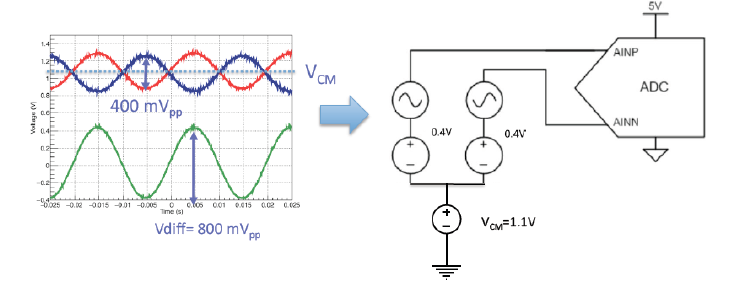
Figure 4. Normal Mode Rejection Ratio measurement scheme.